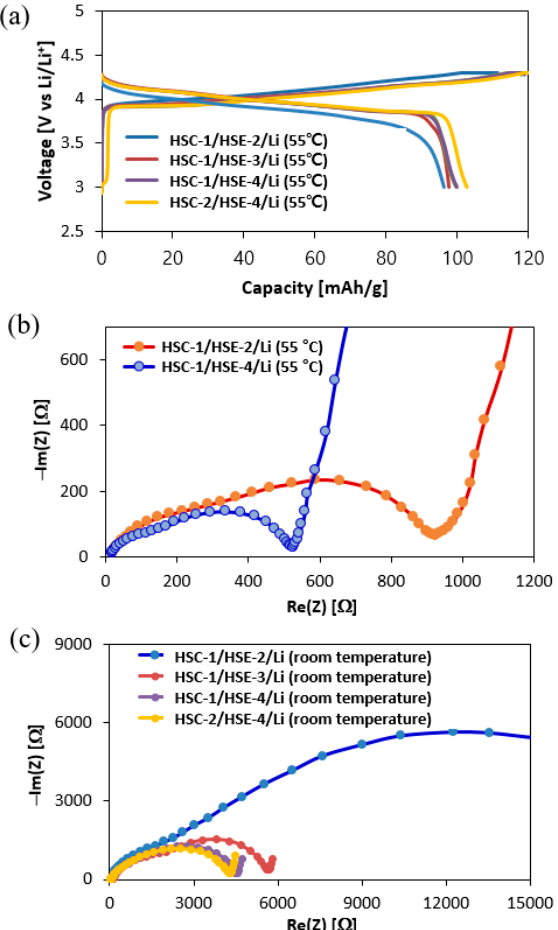
Figure 6. ( a ) 1 st charge ‐ discharge profiles of HSC ‐ 1/HSE ‐ 2/Li, HSC ‐ 1/HSE ‐ 3/Li, HSC ‐ 1/HSE ‐ 4/Li and HSC ‐ 2/HSE ‐ 4/Li at 55 C. EIS profiles of ( b ) HSC ‐ 1/HSE ‐ 2/Li and HSC ‐ 1/HSE ‐ 4/Li at 55 C and ( c ) HSC ‐ 1/HSE ‐ 2/Li, HSC ‐ 1/HSE ‐ 3/Li, HSC ‐ 1/HSE ‐ 4/Li and HSC ‐ 2/HSE ‐ 4/Li at room temperature.